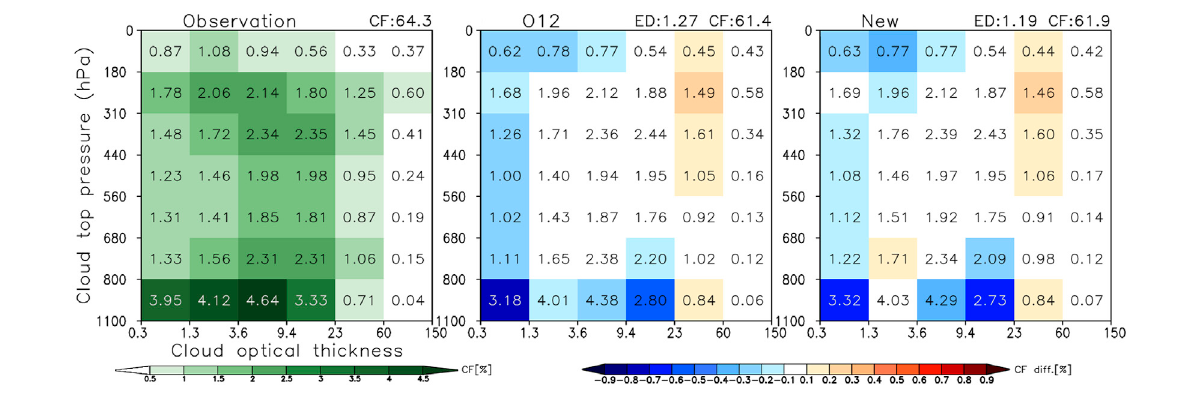
Frontiers in Remote